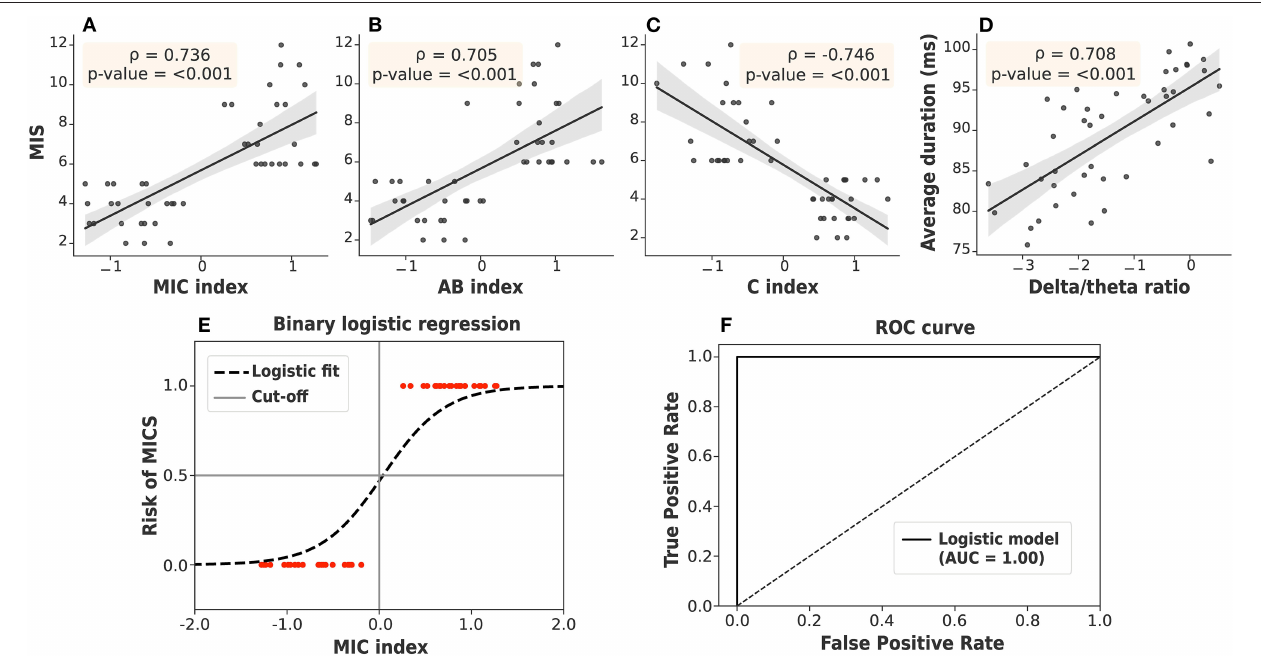
FIGURE 6 | (A) The MIC index, (B) AB index, and (C) C index were strongly correlated with the MIS. (D) The delta/theta ratio was also strongly correlated with the average duration. (E) The MIC index, as a feature in binary logistic regression, discriminated ESRD patients at high and low risk of MICS with 100% accuracy by using train-test split validation. (F) The ROC curve demonstrated a 100% area under the curve (AUC). Gray: 95%